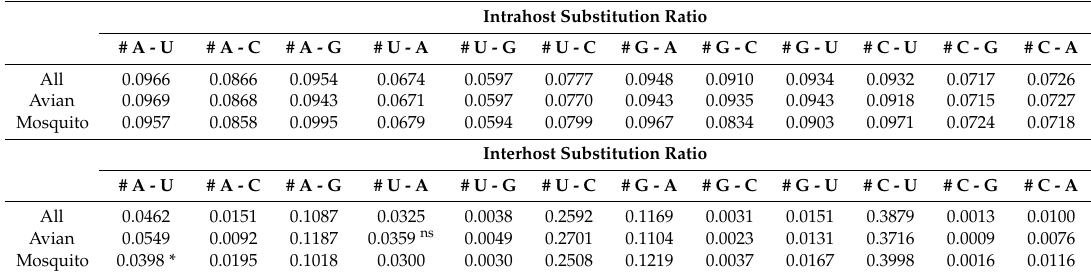
Table 2. The proportion of each type of substitution within inter and intrahost datasets for each host. Intrahost Substitution Ratio